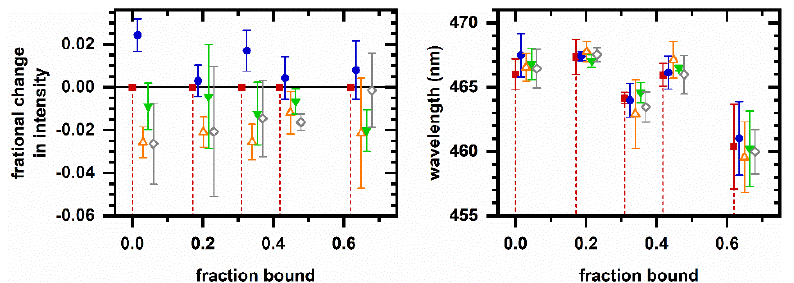
Figure 4. Excited-state emission from NADH and protein solutions during pressure cycling. For both plots, the estimated fraction of NADH bound to MDH is indicated by the drop line; data points after subsequent pressurization and depressurization are offset to the right for clarity. NADH concentration is 5 µ M prior to MDH addition. Color/symbol indicates condition: red/square—Prior to pressurization; blue/circle—After first pressurization; orange/upright triangle—After first depressurization; green/inverted triangle—After second pressurization; and gray/diamond—After second depressurization. Filled symbols are pressurizations to 33.1 MPa; open symbols are depressurizations to 1.4 MPa. Left, fractional change in emission intensity after changing pressure. Right, intensity-weighted average emission wavelength. Error bars are standard deviations of at least five measurements.